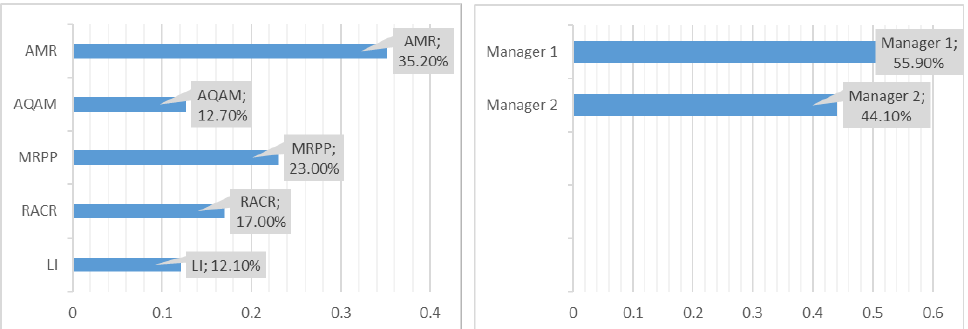
Figure 4. Scenario 2 (own processing).